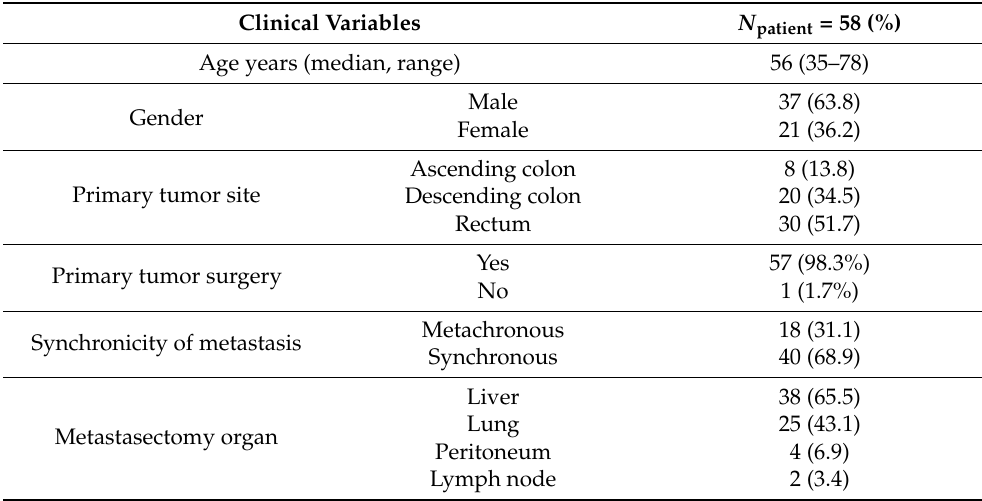
Table 1. Patient